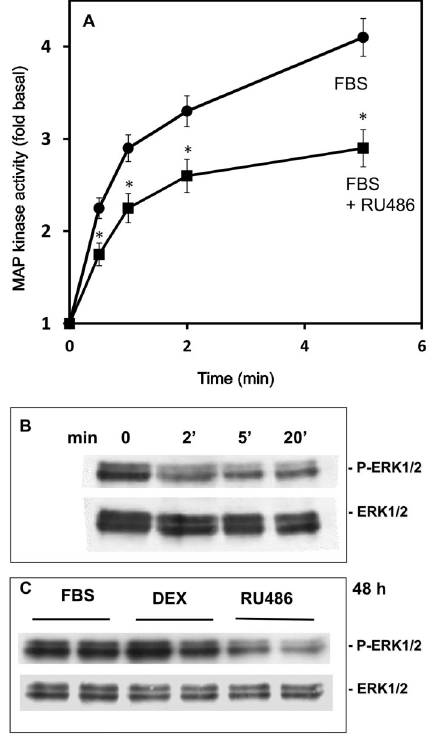
Figure 6. Effect of the exposure of SK-N-SH cells to 10 m M RU486 on MAP kinase activity ( A ), and p-ERK and total ERK immunoreaction by a time course observation ( B ). C , p-ERK and total ERK immunoreaction measured after a 48-h exposure to FBS, 10 m M RU486, or 10 m M dexamethasone (DEX); cells exposed to FBS and dexamethasone were analyzed as control treatments. The cell extracts were subjected to western blot analysis to detect phosphorylated and total ERK. Data in panel A are reported as means ± SD. *P o 0.05 vs FBS (ANOVA).